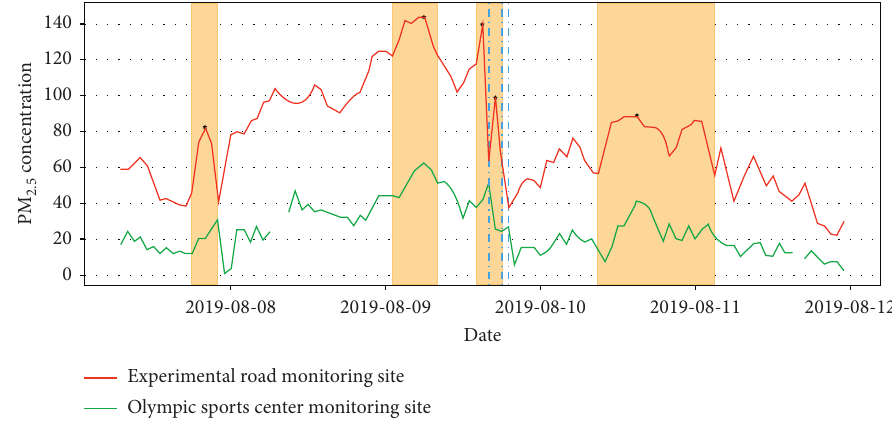
Figure 16: Comparison between experimental monitoring site and Olympic Sports Center monitoring site.